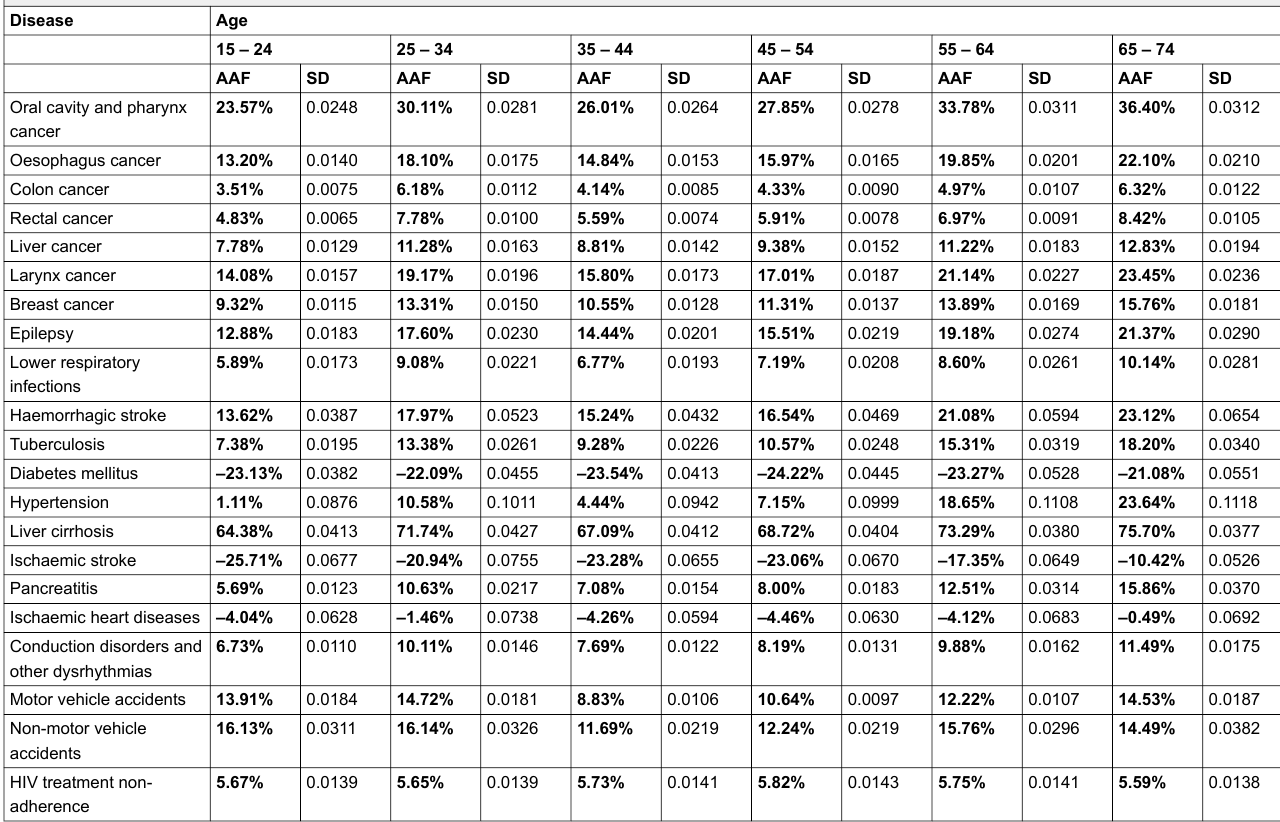
Table A2: Alcohol-attributable fractions, women